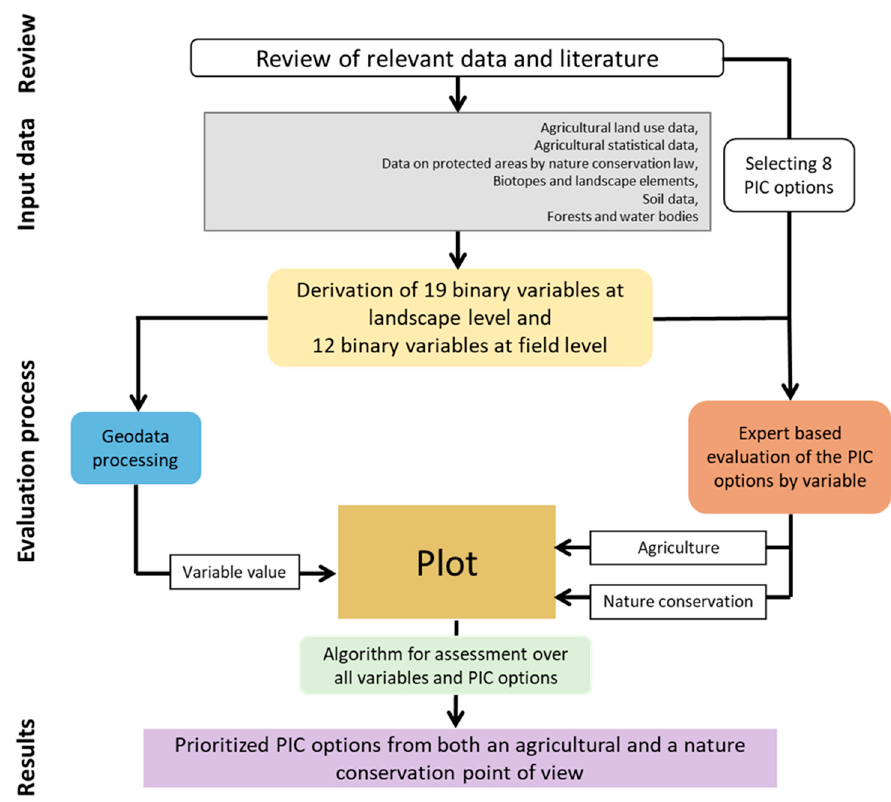
Figure 2. Overview of the entire approach and process of the development of a regional map for PIC measures.